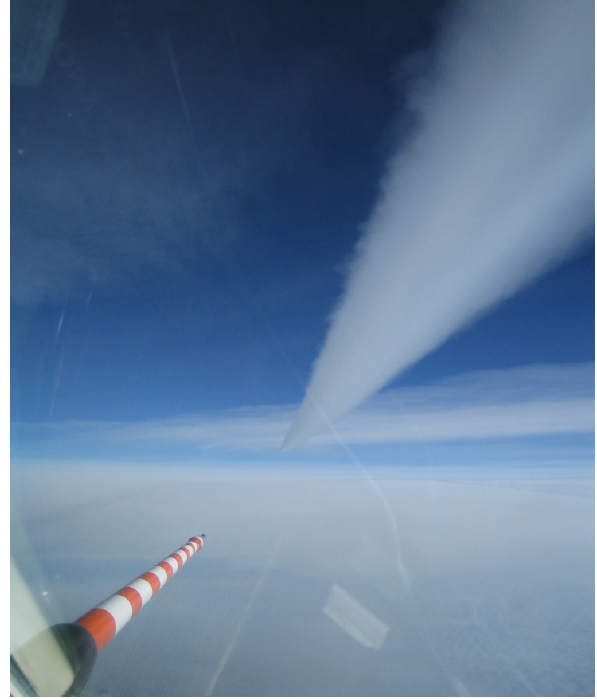
Fig. 1. Photo taken from the Falcon cockpit a few minutes prior the penetration to the A380 contrail (courtesy of T.